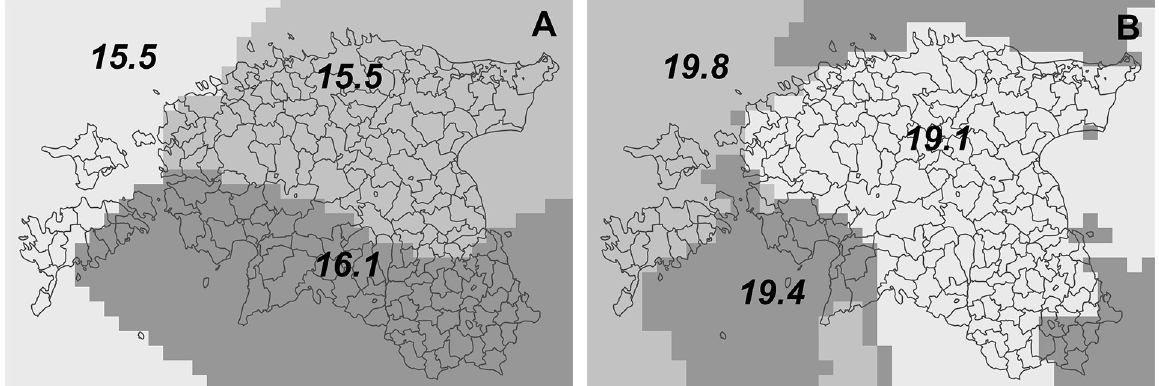
Fig. 4. Summer (JJA) air temperature (°C) regions and their average air temperature during the reference period 1971–2000 ( A ) and according to RCP8.5 for the period 2071–2100 ( B ).